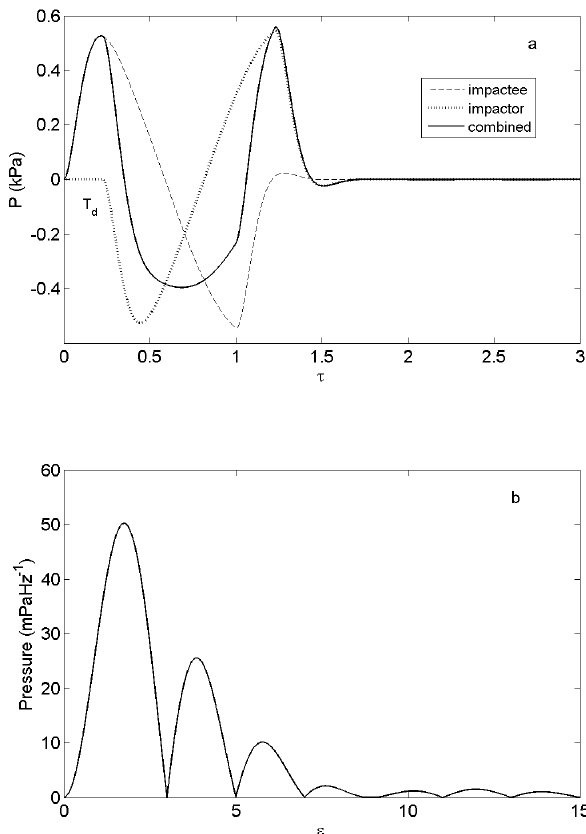
Figure 2. Calculations for two glass spheres of the same size im- pacting with radius a = 0 . 02m and impact velocity U = 0 . 3ms − 1 . (a) The time domain solution using Eq. (1) for the pressure, P , with normalised time τ = t/t o and (b) the frequency domain solution using Eq. (2) for the spectral pressure with normalised frequency ε = f/f o